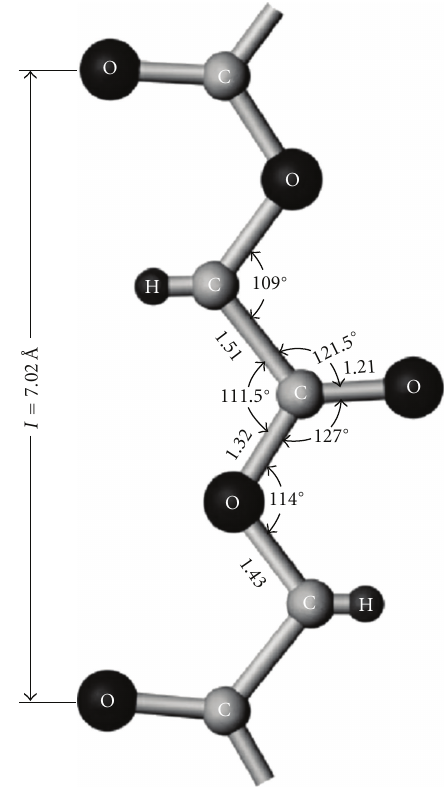
Figure 1: Molecular dimensions of poly(glycolic acid).